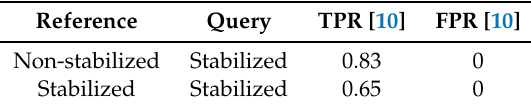
Table 4. Performance of Source Identification of digitally stabilized video (using ffmpeg) using both non-stabilized and stabilized references reported in [10], in terms of True Positive Rate (TPR) and False Positive Rate (FPR).